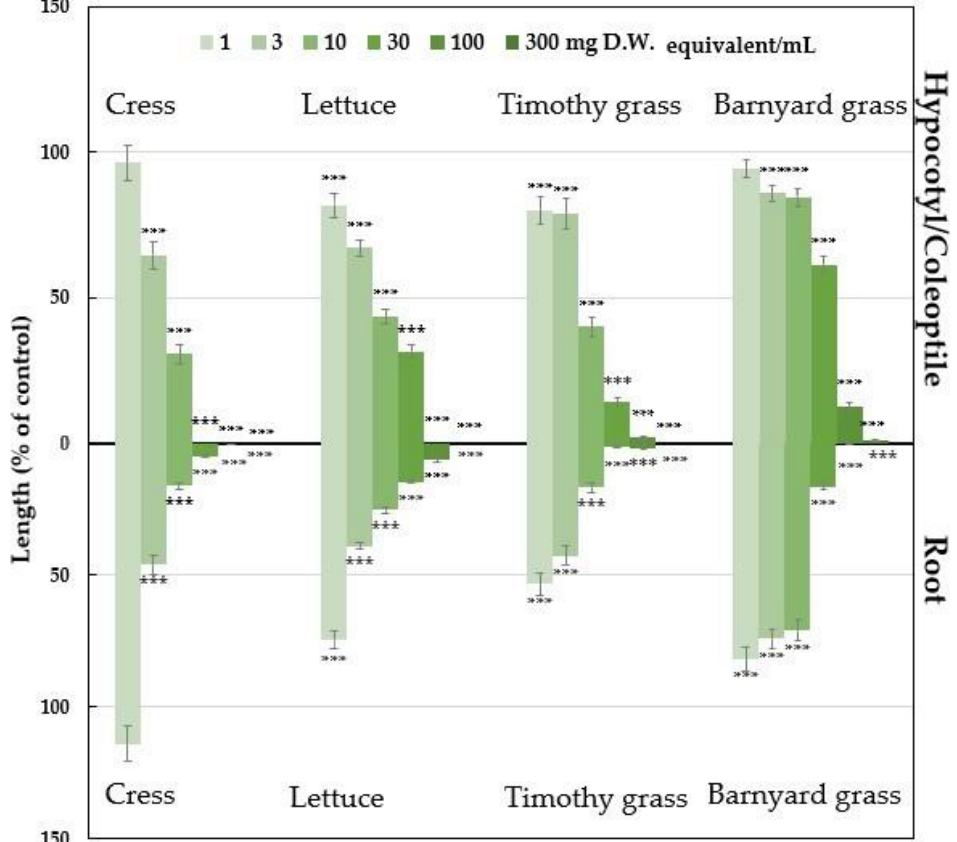
Figure 1. Effect of Polygonum chinense plant extracts treated with different concentrations of 0.001, 0.003, 0.01, 0.03, 0.1, and 0.3 mg D.W. equivalent extract/mL (D.W.: dry weight) on the hypocotyls/coleoptiles and the root length of four test plant species. The means ± SE from six replications with 10 seedlings per replication (n = 60) for each determination are shown. *** represents a statistically significant difference between the control and the treatment: p < 0.001 (post hoc Tukey’s test).